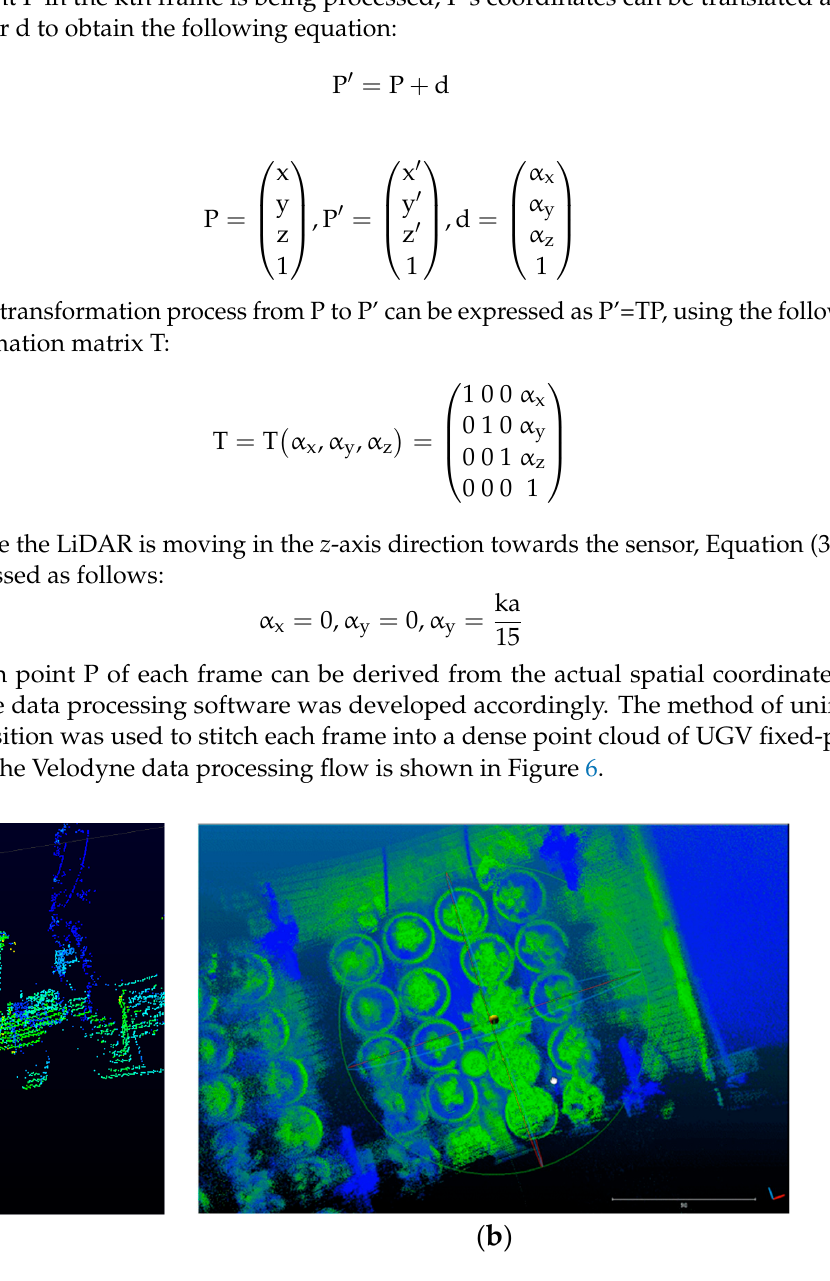
Figure 6. Velodyne data processing flow. ( a ) Velodyne raw data. ( b ) Dense point cloud of UGV fixed-point block.